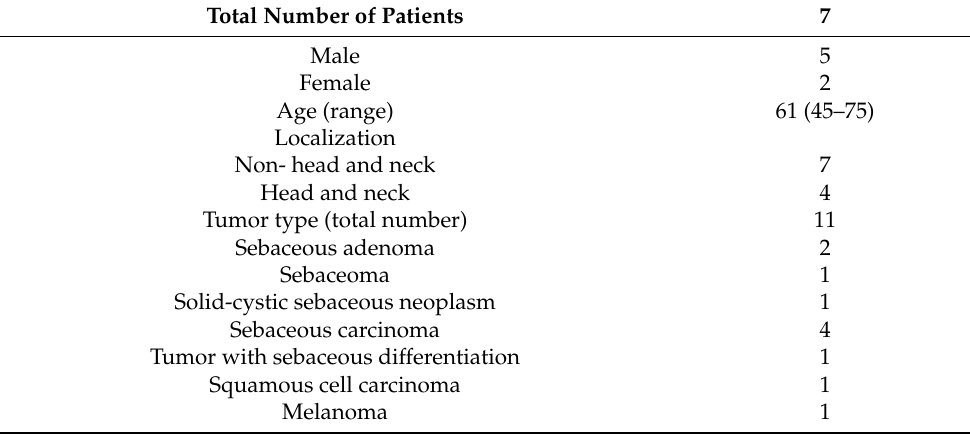
Table 1. Demographic data.